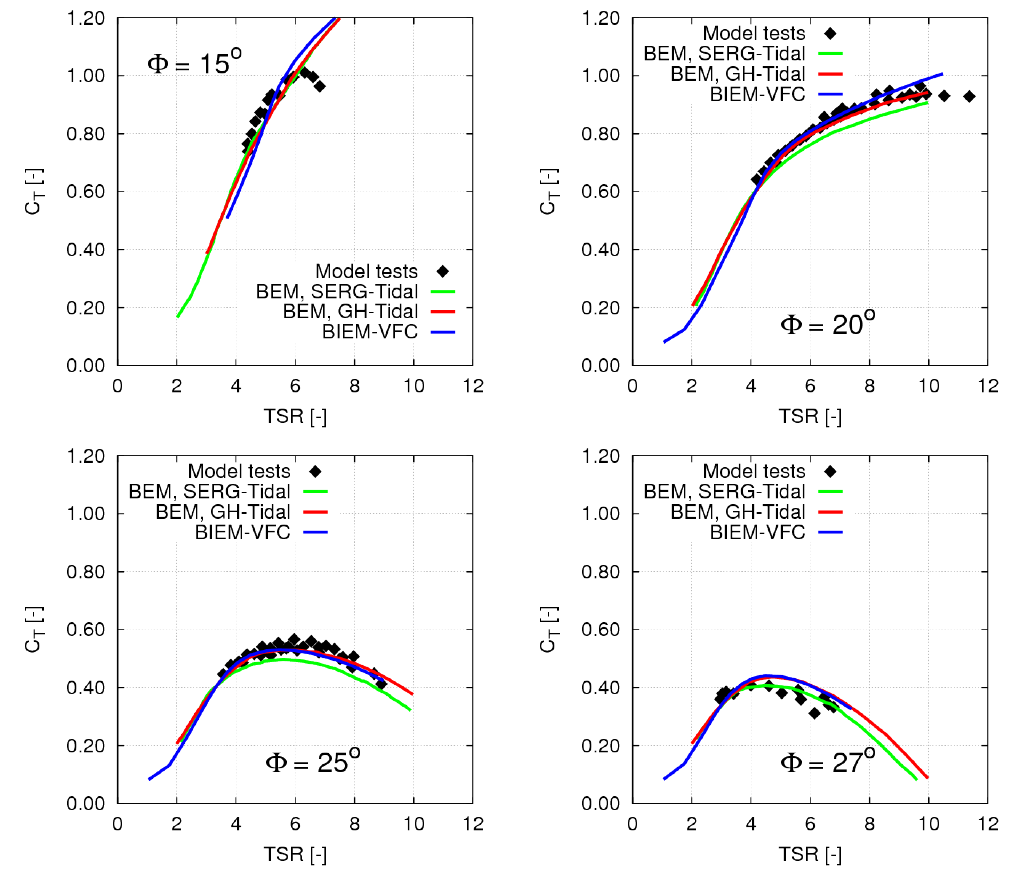
Figure 28. UoS-VP turbine performance predictions by BIEM-VFC compared to results of BEM models from [25]: thrust coefficient C . Pitch settings Φ = 15 ◦ to 27 ◦ T